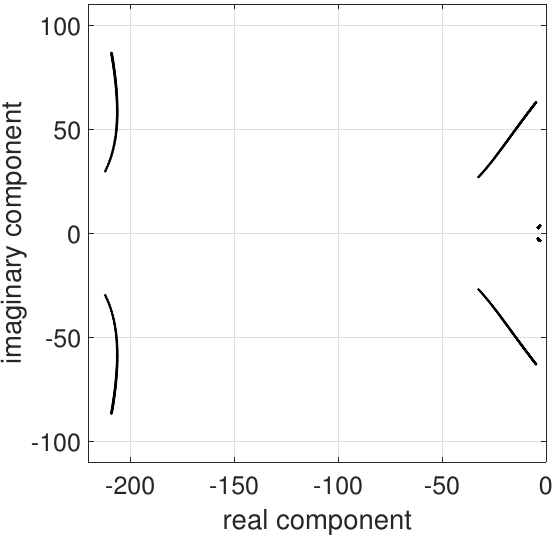
Figure 11. Root loci of (40) in function of λ